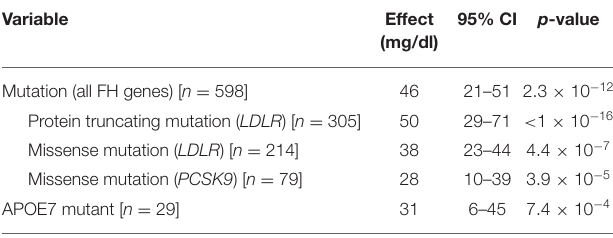
TABLE 2 | Mutation type and its association with LDL cholesterol.